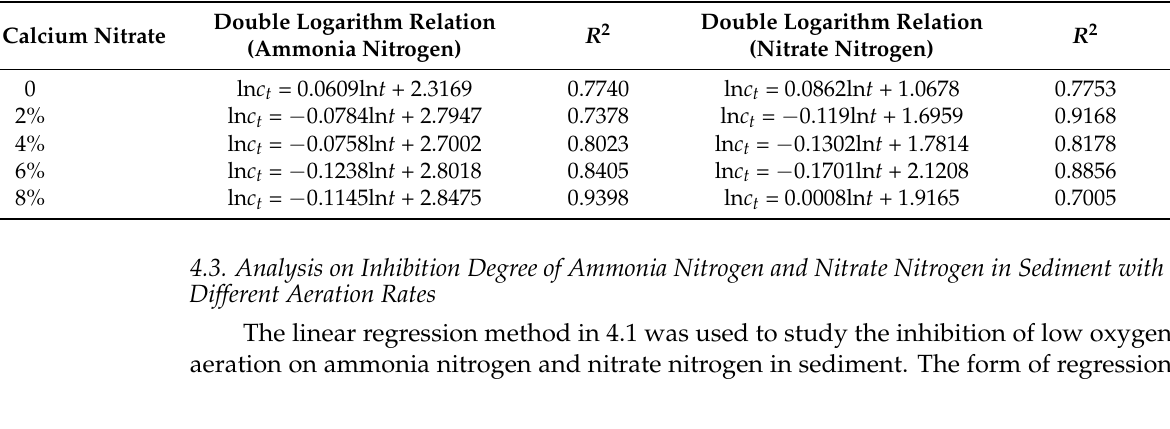
Table 3. Double logarithm linear expression between ammonia nitrogen/nitrate nitrogen concentra- tion in overlying water and test days.